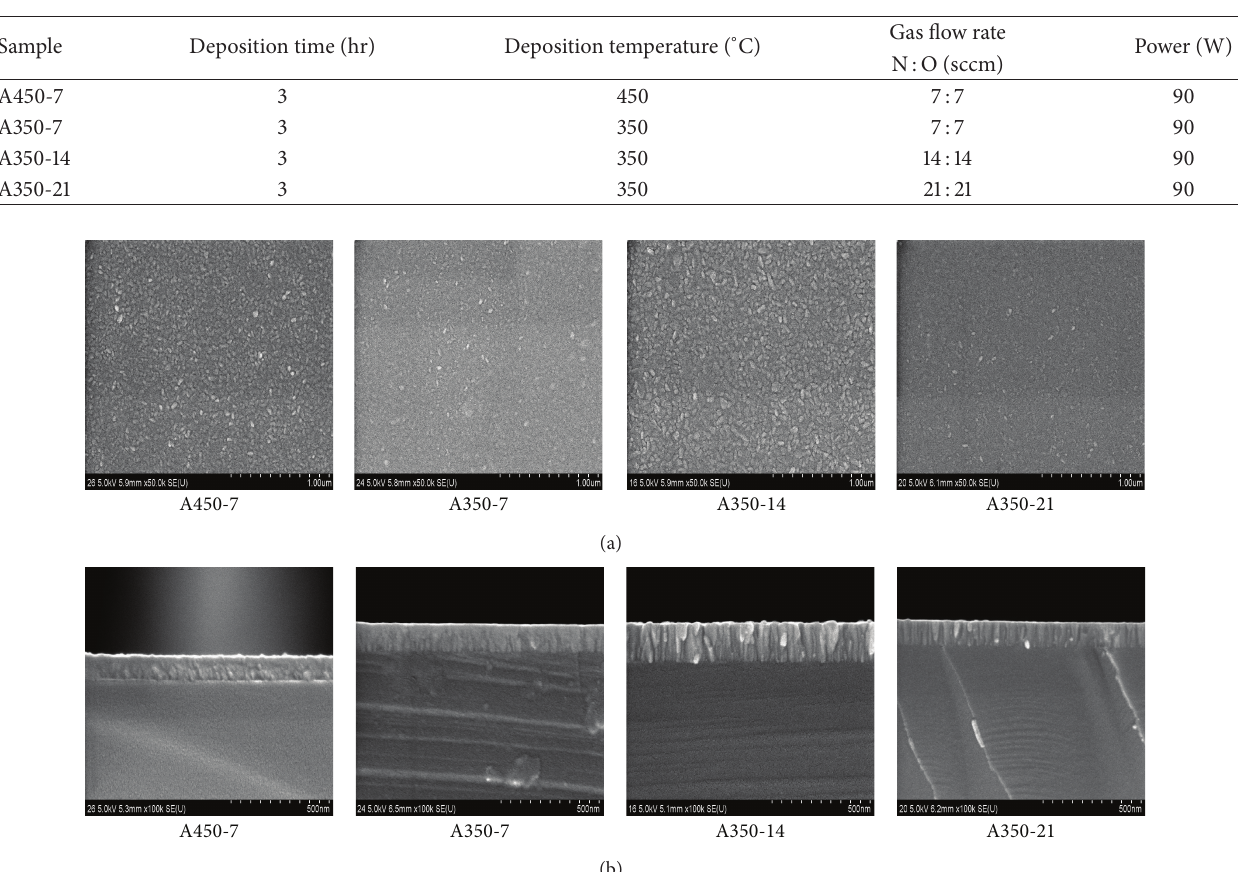
Figure 1: SEM images of (a) the surfaces and (b) the cross sections of the AZO thin